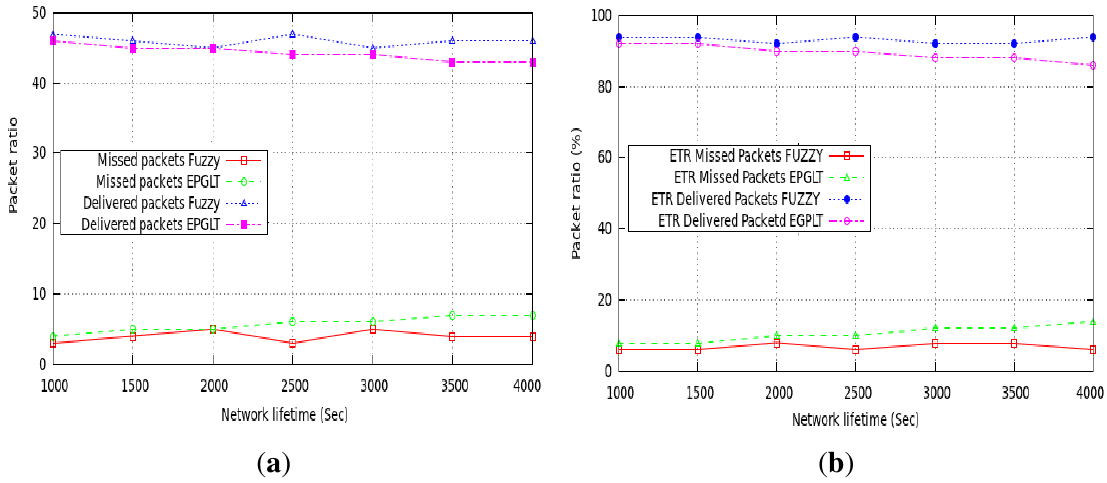
Figure 8. Packet delivery ratio. ( a ) Network lifetime; ( b ) packet